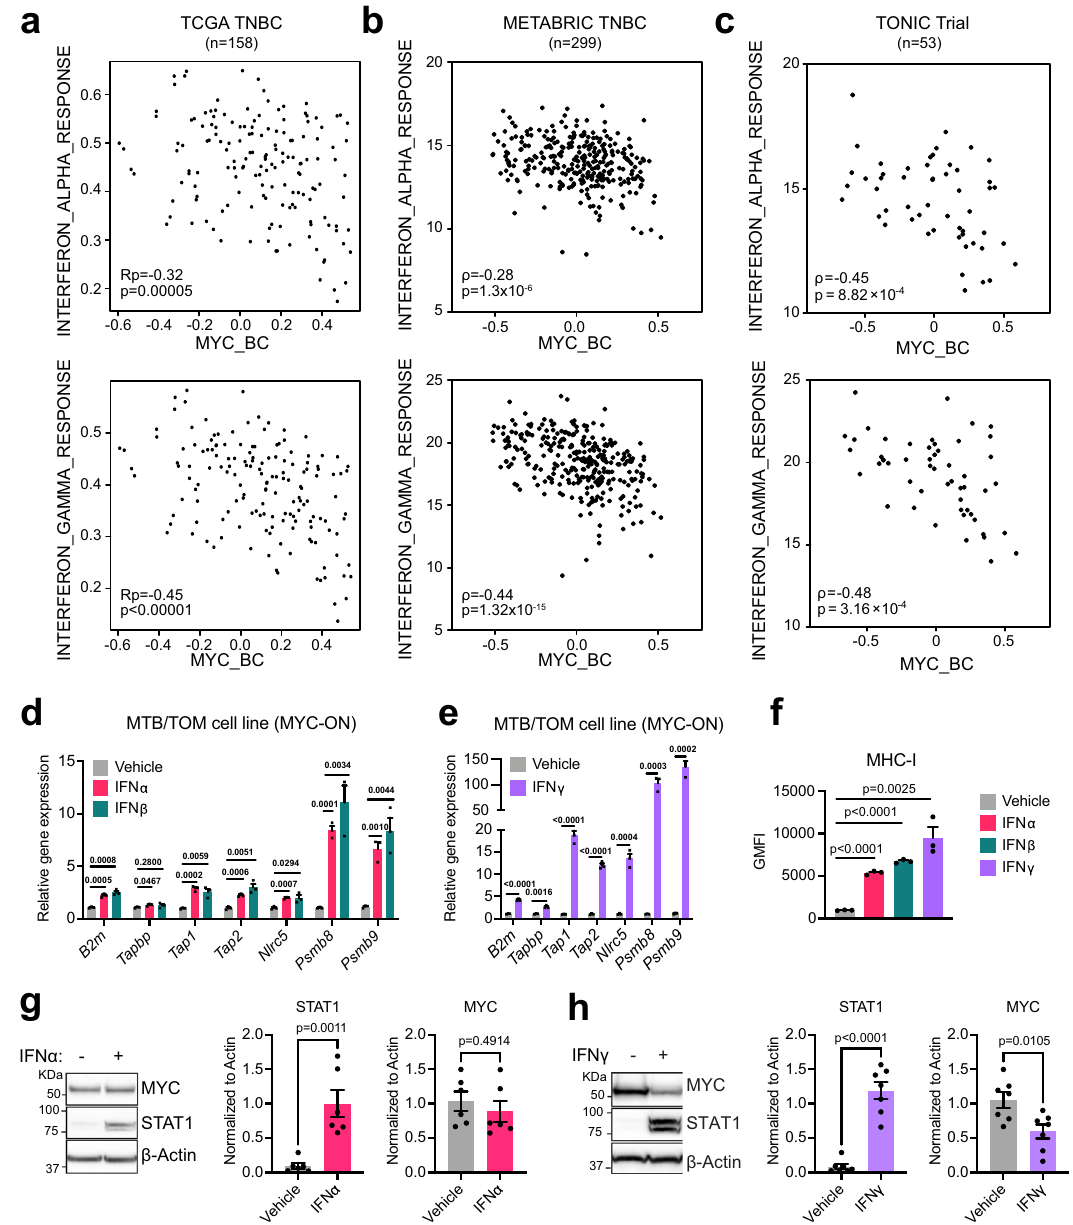
Fig. 3 Interferon signaling rescues MHC-I in MYC-elevated cells. a – c Scatter plot correlation tested between the expression of Hallmark Interferon Alpha Response signature or Hallmark Interferon Gamma Response signature and the MYC_BC signature in a TCGA TNBC patients, Pearson ’ s coef fi cient (Rp), adjusted p -value (Benjamini – Hochberg FDR corrected); b METABRIC TNBC, ρ , Spearman ’ s r and exact p -value; and c TONIC Trial, ρ , Spearman ’ s r and exact p -value. d , e Gene expression analysis after 72h of d vehicle, interferon alpha, and interferon beta, or e interferon gamma treatment in the presence of doxycycline, in MTB/ TOM cells grown in vitro culture. Representative experiment with three samples per condition shown. Mean±S.E.M, unpaired t -test with Benjamini – Hochberg FDR = 0.05, adjusted p -values displayed across the bars. Trends repeated with three independent cell passages. f Flow cytometry results displayed as geometric mean fl uorescence intensity (GMFI) for MHC-I in MTB/TOM cell line in vitro culture after 72h of treatment. Representative experiment with three samples per condition shown. Mean±S.E.M, two-sided, unpaired t -test, exact p -values. Trends repeated with three independent cell passages. g , h Left: Representative western blots showing MYC levels in the MTB/TOM cell line after 72h of treatment with g interferon alpha ( n = 6 independent cell passages) or h interferon gamma ( n = 7 independent cell passages). Right: densitometry ratio of MYC or STAT1 to ß-actin shown from independent cell passages. Two-sided, unpaired t -test, exact p -values. Source data are provided in the Source Data fi le. Source data for panel c provided at EGA (EGAS00001003535).